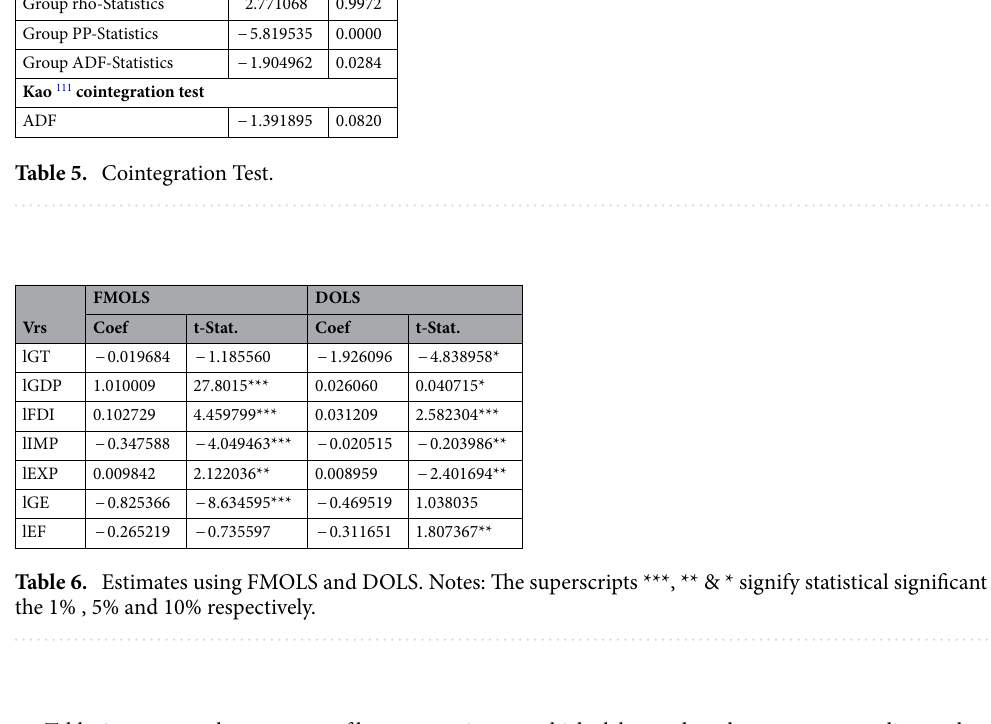
Table 6 represents the outcomes of long-run estimates, which elaborated on the nexus among climate change (GHG emissions), green technology development (GT), energy efficiency (EF), green energy (GE), trade (IMP and EXP), economic growth (GDP), and foreign direct investment (FDI). DOLS research reveals that a 1% increase in FDI raises emissions by 31% while a 1% increase in imports lowers emissions by 2%. The result is in line with Zhang and Zhou, Liobikienė and Butkus, and Balsalobre-Lorente et al. 40,119,120 results. The projected GDP result is positive and statistically significant at 9%, implying that a 1% increase in GDP increased GHG emissions by 2%.This confirms that the growth of GDP enhanced the emissions, which in turn polluted the environment. The result is consistent with Sarkodie and Adams 121 .